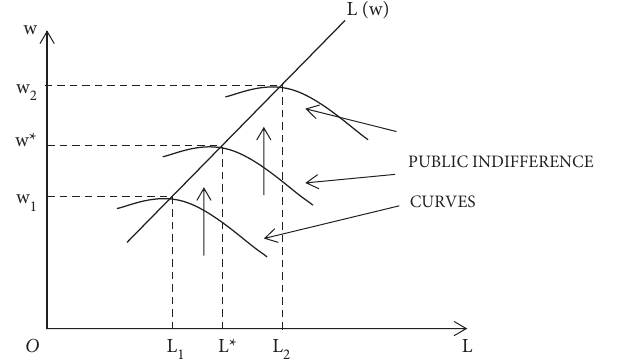
Figure 4: Public indifference curves.